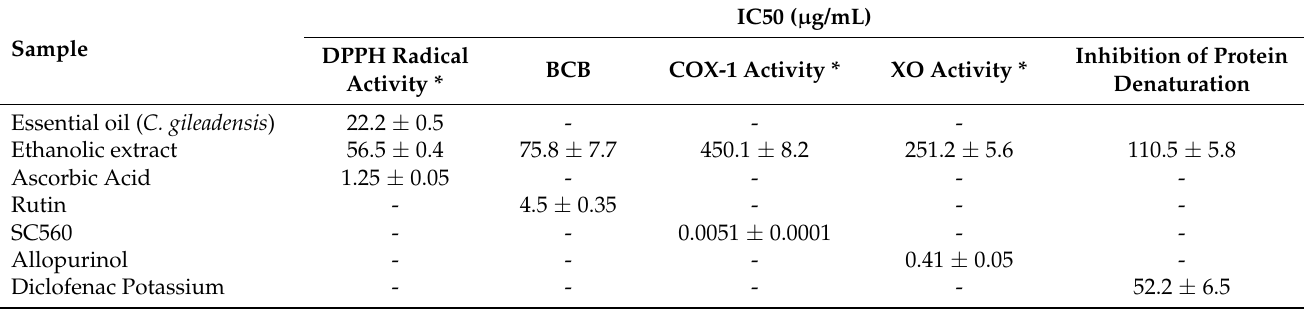
Table 5. In vitro DPPH radical scavenging, BCB assay, XO activity and inhibition of protein denatura- tion